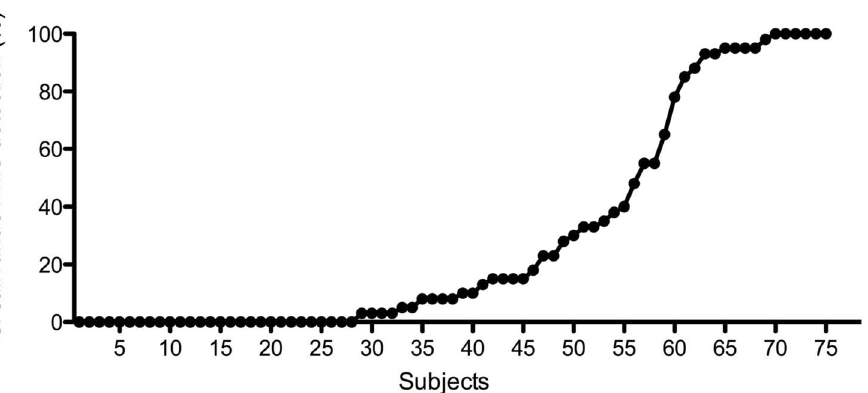
Figure 1. Total proportion of bacteriocin-like inhibitory substance producing Streptococcussalivarius in saliva samples in all subjects tested prior to probiotic treatment.